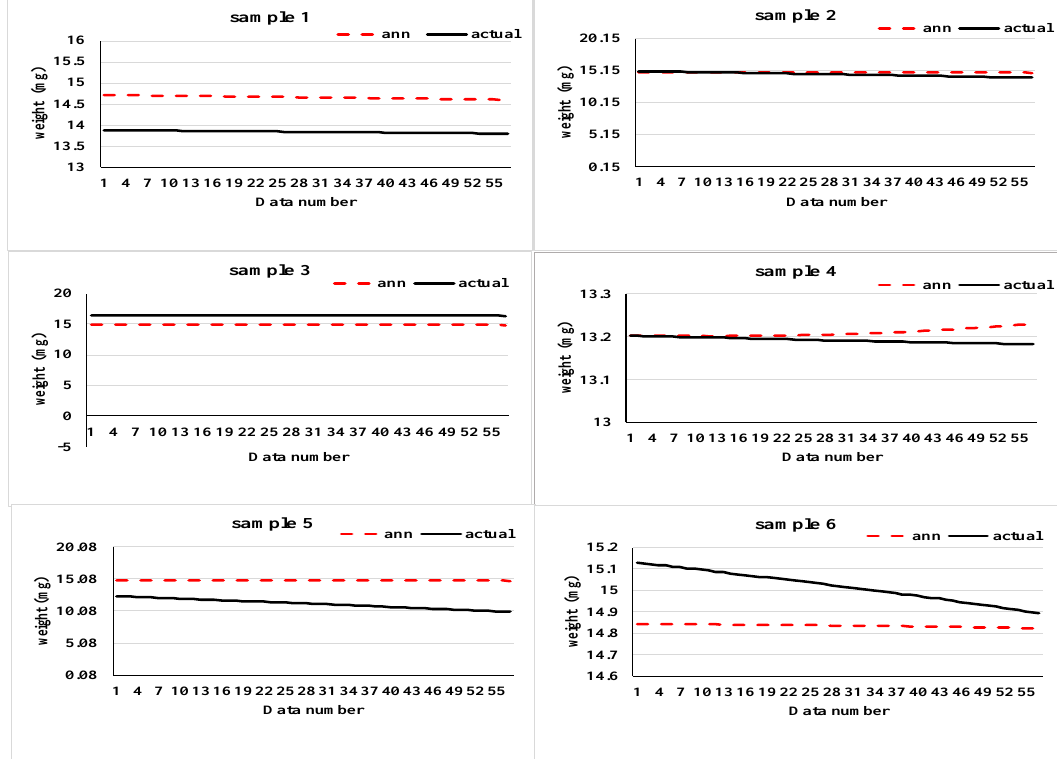
Figure 6. Thermal stability validation of experimental and ANN values.